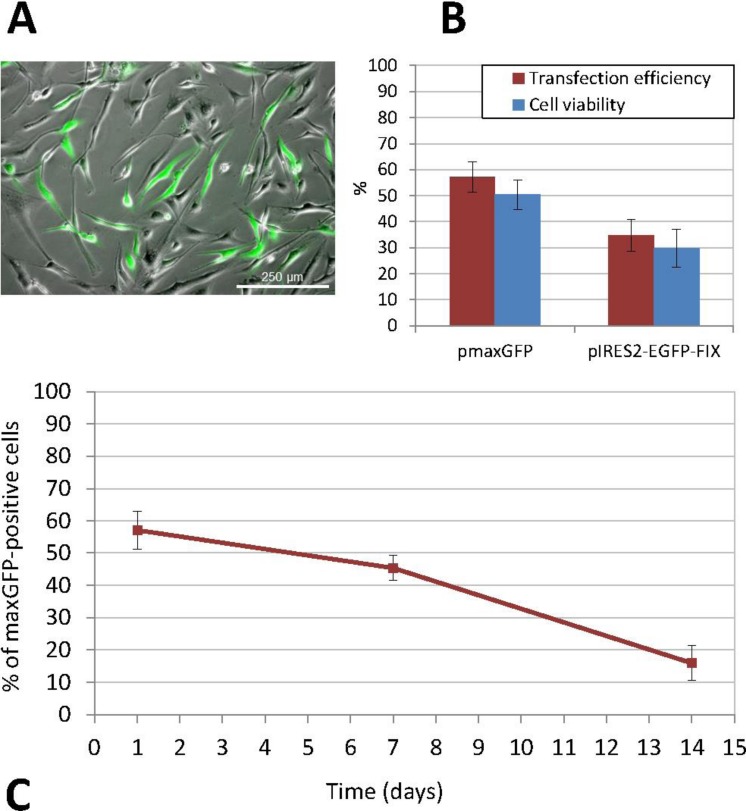
Transfection of human ASCs by nucleofection.(A) GFP expression in ASCs transfected with pIRES2-EGFP-FIX plasmid, detected by fluorescence microscopy (original magnification 10×). (B) Percentage of viable and GFP-positive cells 24 h after nucleofection with pmaxGFP and pIRES2-EGFP-FIX. Mean ± standard deviation (SD) values are represented. Both efficiency and viability were higher for the commercially available plasmid (pmaxGFP™) supplied by the nucleofection kit manufacturer (C) Time-course analysis of GFP expression in nucleofected ASCs using pmaxGFP™ plasmid. The percentage of fluorescent cells stood at 45.41% ± 3.95 at 7 days from transfection and 15.92% ± 5.45 at 14 days.